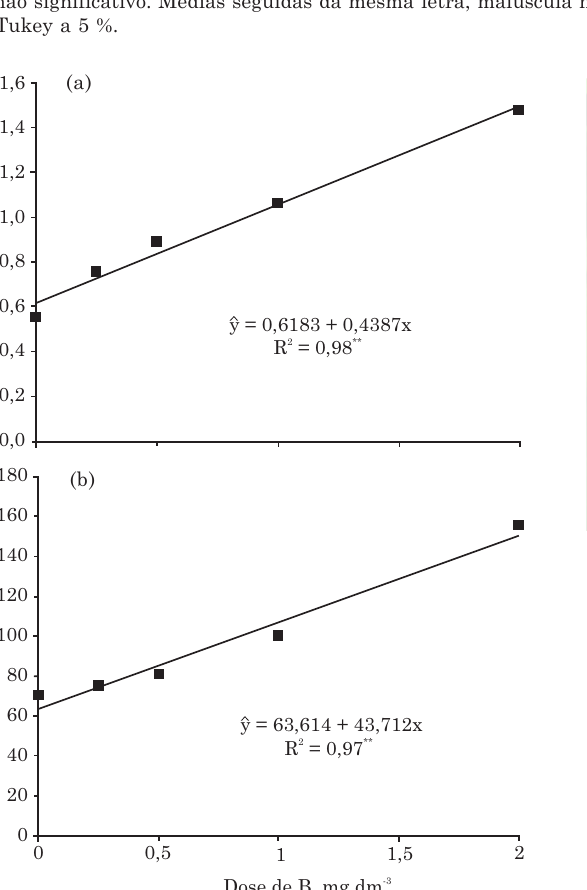
Figura 4. Teor de B no solo (a) e no tecido foliar da soja (b) em função das doses aplicadas ao solo.